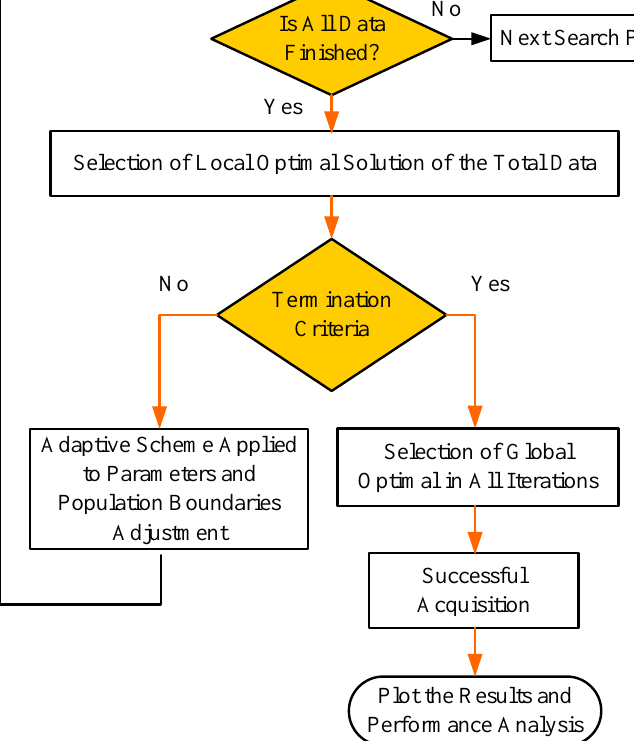
Figure 1. For each parameter, all individuals of the current population are evaluated and a